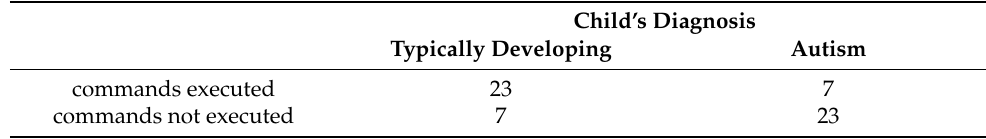
Table 3. The amount of autistic and typically developing children who did, or did not, imitate the robot’s movements in the Dance with me